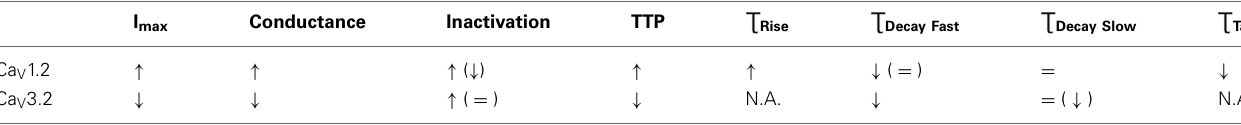
Table 1 | General qualitative effect of HP found in our study on channel